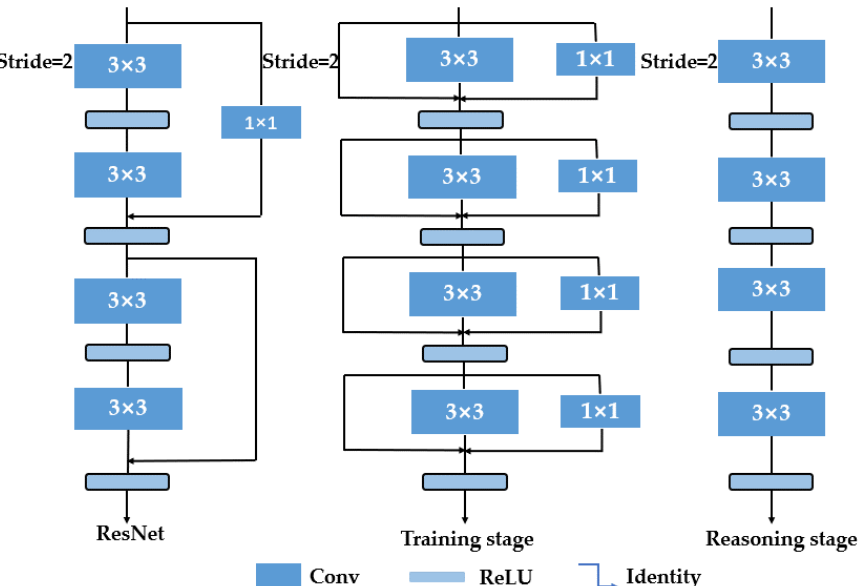
Figure 3. RepVGG network architecture. Left image: residual structure in ResNet. Middle image: training phase, using a similar multibranch residual structure inspired by ResNet. Right image: inference stage, converting all the network layers to Conv 3 × 3 through the reparameterization process. The rectified linear unit is a piecewise linear activation function that outputs the input directly if it is positive and zero otherwise [22].